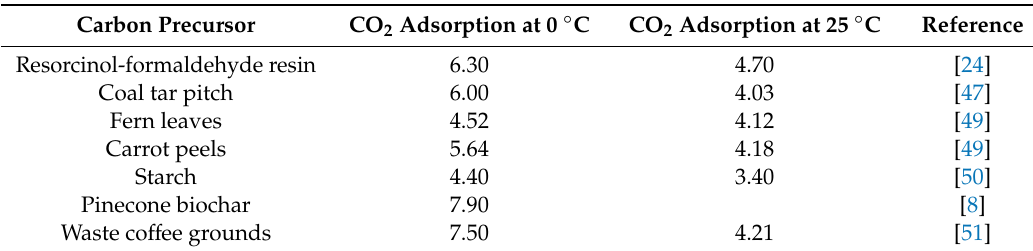
Table 2. Comparison of the CO 2 adsorption values for potassium salt-activated carbon materials from di ff erent precursors at 1